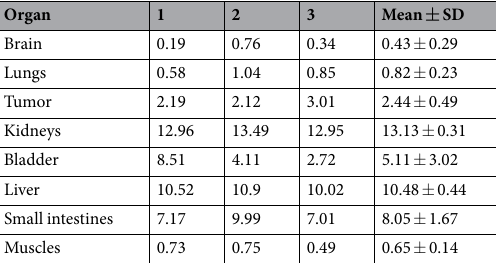
Table 1. The maximum standard uptake value (SUVmax) of three patients for 18